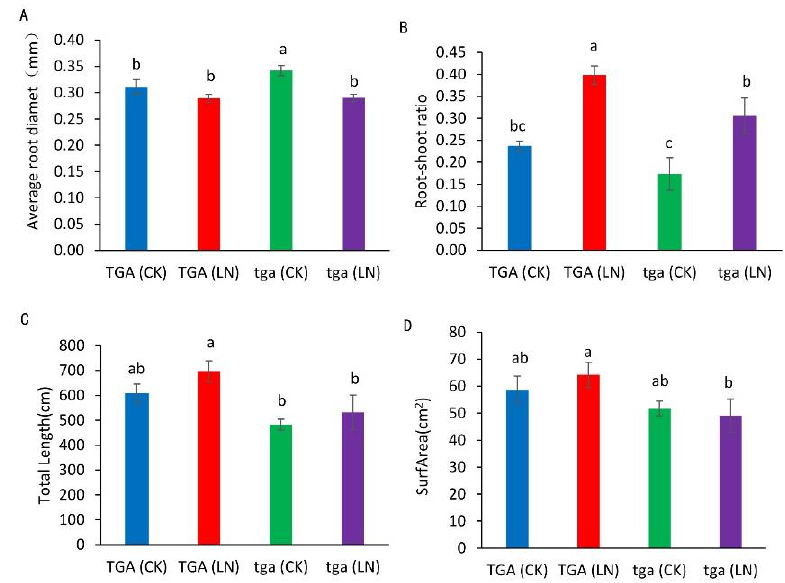
Figure 7. Root differences between wild-type TGA and mutant tga at two nitrogen levels. ( A ) Average root diameter, ( B ) ratio of fresh weight to root shoot, ( C ) total root length, ( D ) root surface area. Different letters indicate significant differences at p < 0.05 between different groups according to the Duncan test. CK, 4 mmol L − 1 ; LN, 0.04 mmol L − 1 NO 3 − .